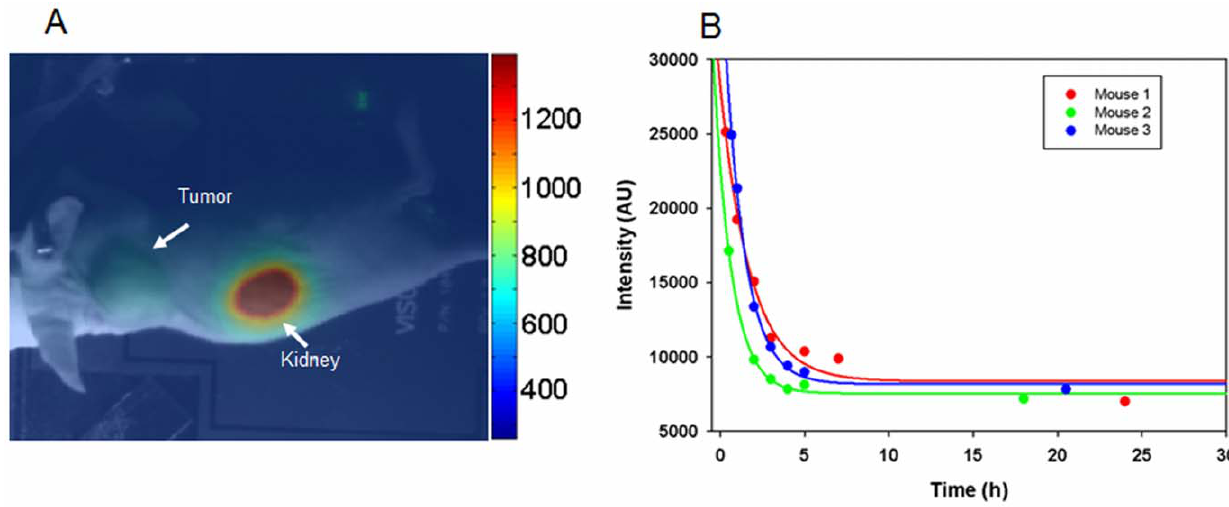
Figure 5. Distribution and kinetics of fluorescence signal in mice with HER2-positive tumor injected with "off-target" Affibody- DyLight-750 conjugate. A. Representative CCD camera image of BT-474 mouse three hours post injection with 10 m g of Z Taq -Affibody-DyLight-750 conjugate. B. One-phase decay function y ~ a exp ( { kx ) z c in MatLab software was used to quantify fluorescence kinetic. Blue, red, and green represent signal quantified for each mouse in the experiment.